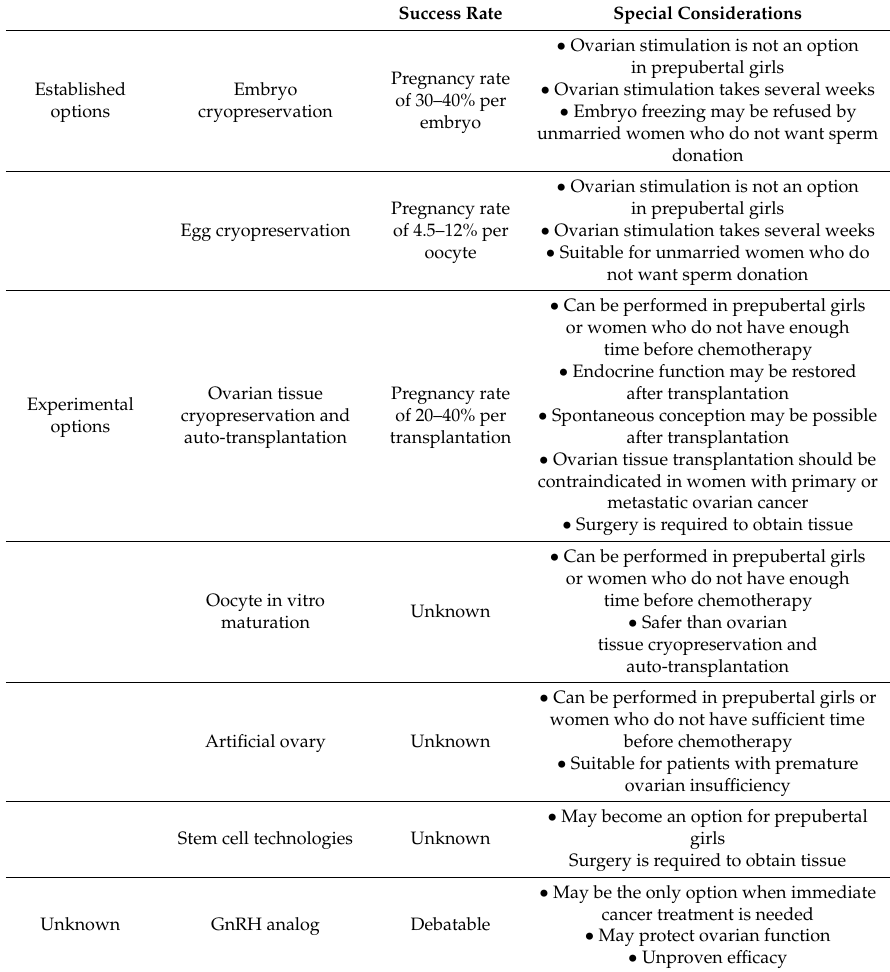
Table 2. Summary of major options for female fertility preservation and restoration after